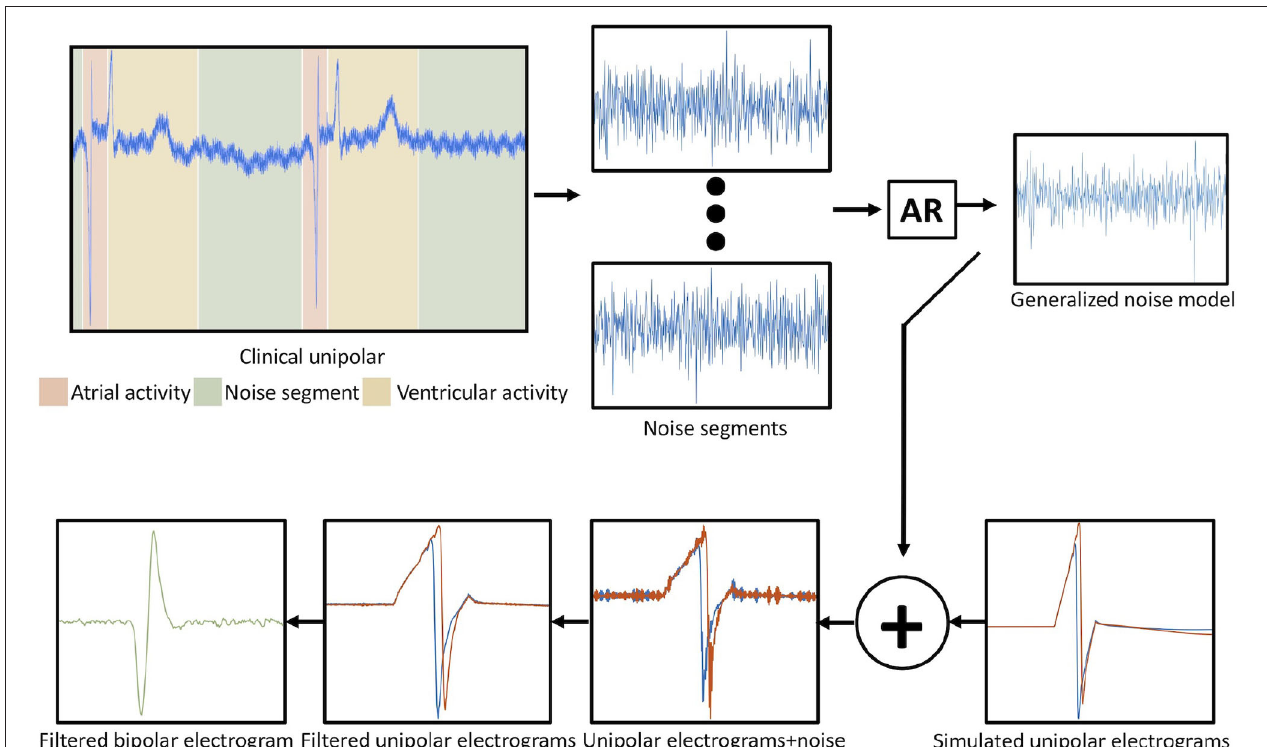
FIGURE 2 | Workflow to generate the noise model and the addition to the simulated signals. In the top left corner, the different segments of the activity from a clinical unipolar electrogram are depicted. Autoregression was applied to the noise segments. The noise model was used to estimate the simulated unipolar electrogram with noise. Afterward, the unipolar electrograms (red and blue trace) were filtered, and the bipolar electrogram was calculated by subtracting the unipolar electrograms. Reused from Sánchez et al.